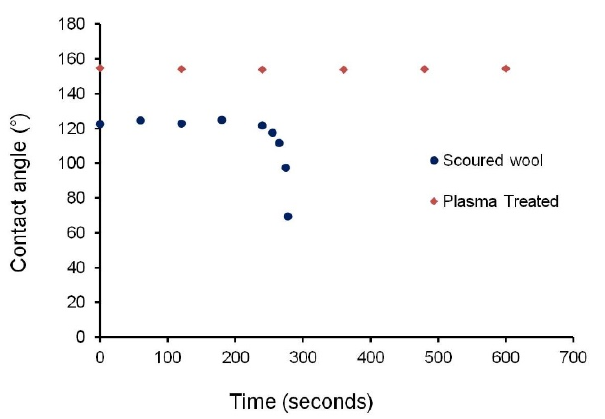
Figure 8. Change of contact angle with time for scoured and plasma-treated wool samples.